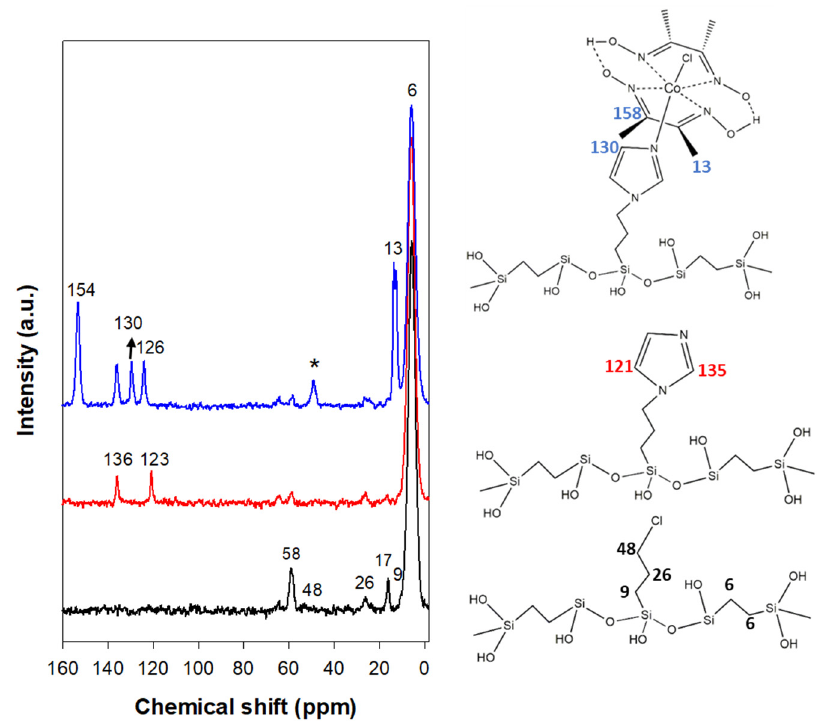
Figure 4. 13 C CP/MAS NMR spectra of Cl-EtPMO (black line), Im-EtPMO (red line), and Im-EtPMO- Co (blue line). Predicted chemical shifts on the right. *—low field.